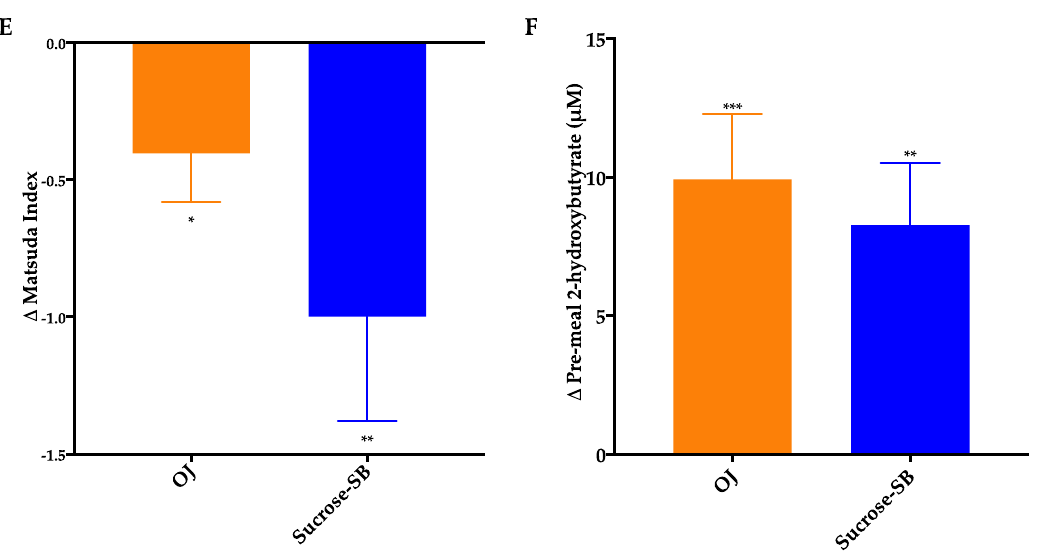
Figure 5. Metrics of insulin sensitivity measured by oral glucose tolerance test (OGTT) and the metabolite, 2-hydroxybutyrate. Glucose curves during the OGTT before (black line) and after (blue line) consumption of either ( A ) OJ or ( B ) sucrose-SB for two weeks; Insulin curves during the OGTT before (black line) and after (blue line) consumption of either ( C ) OJ or ( D ) sucrose-SB for two weeks; ( E ) Changes in Matsuda Index; ( F ) 2-hydroxybutyrate concentrations measured after a 4-h fast. * p < 0.05, ** p < 0.01, *** p < 0.001 LS mean of change different from zero.